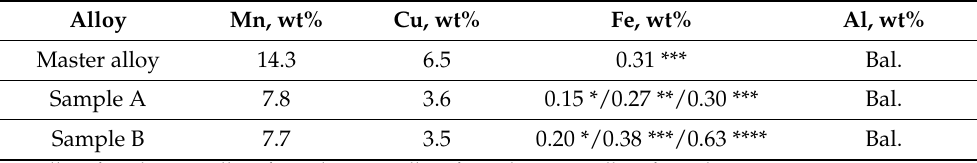
Table 1. Chemical composition of the studied materials. Alloy Mn, wt% Cu, wt% Fe, wt% Al, wt% Master